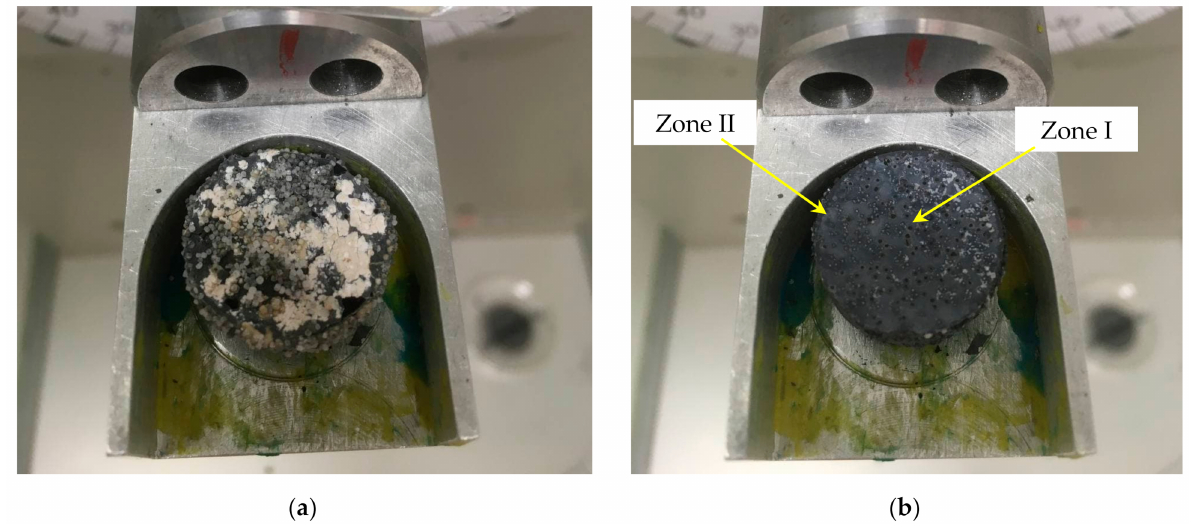
Figure 8. General view of the Ti ( a ) and Ti5Al2V ( b ) alloys’ specimens after HSC testing ( a ) and after rinsing in hot water ( b ).